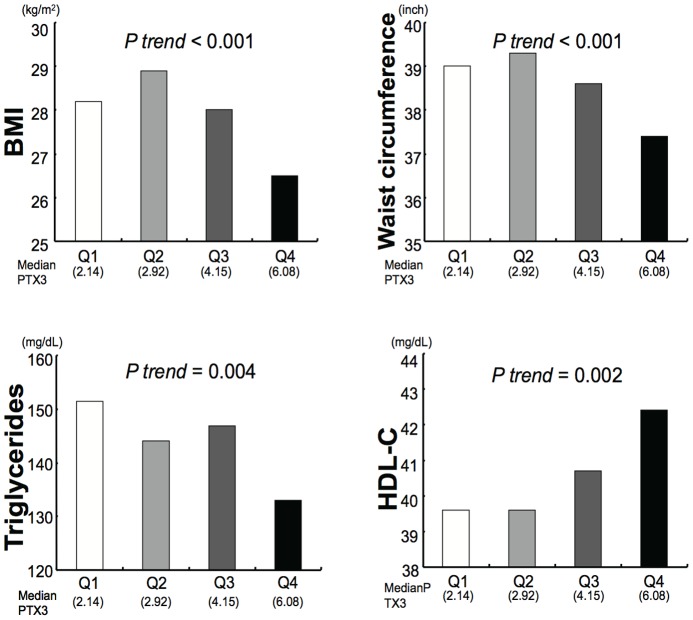
PTX3 levels associate adversely with metabolic syndrome components.Mean values of selected characteristics (BMI, waist circumference, triglyceride, and HDL cholesterol) by quartile of PTX3. Mean values were estimated from linear regression models, adjusted for age.